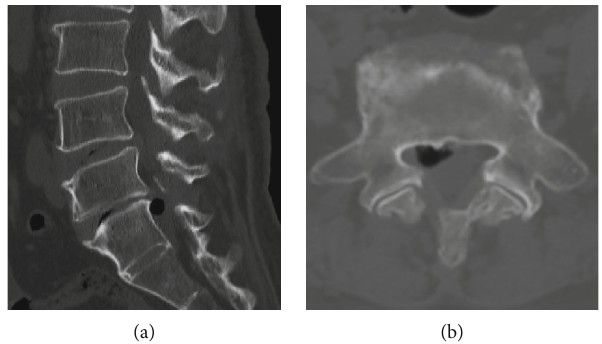
Figure 3: CT reveals a single large epidural gas bubble mimicking disc herniation on MRI as shown in axial (a) and sagittal (b) cuts. A coexisting vacuum disc phenomenon indicates the presumed origin of the gas